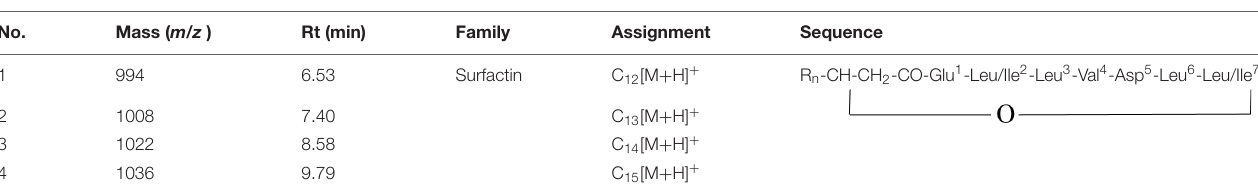
TABLE 2 | Assignment of the structures of lipopeptides by LC-ESI-MS/MS in this study. No. Mass ( m/z ) Rt (min) Family Assignment